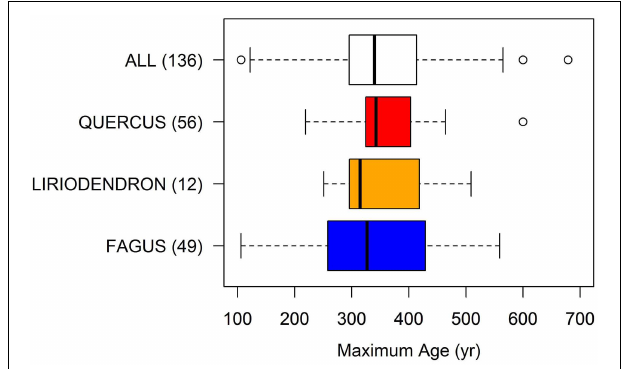
FIGURE 2 | Boxplots of the maximum age found for all temperate deciduous trees in our dataset and separately for the main genera. Within parentheses, the number of trees in each boxplot. The central bar is the median, the margins of each box are the first and third quartile, the whiskers are at ± 1.57 interquartile range and external points are outliers.